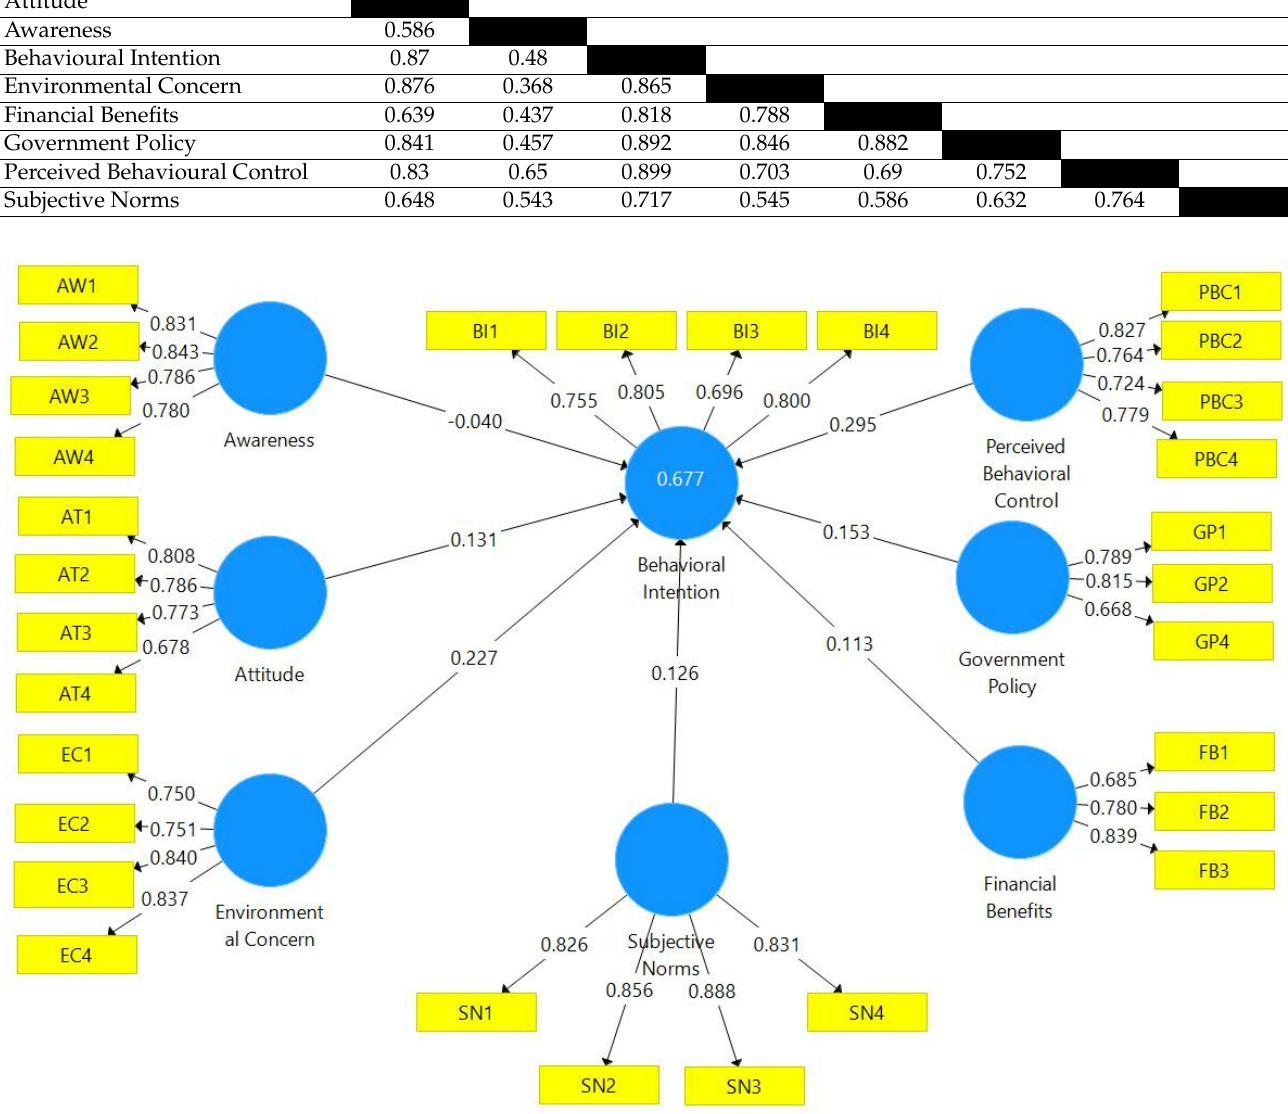
Figure 2. Loadings on measurement model. Table 2. Construct Reliability and Convergent Validity.